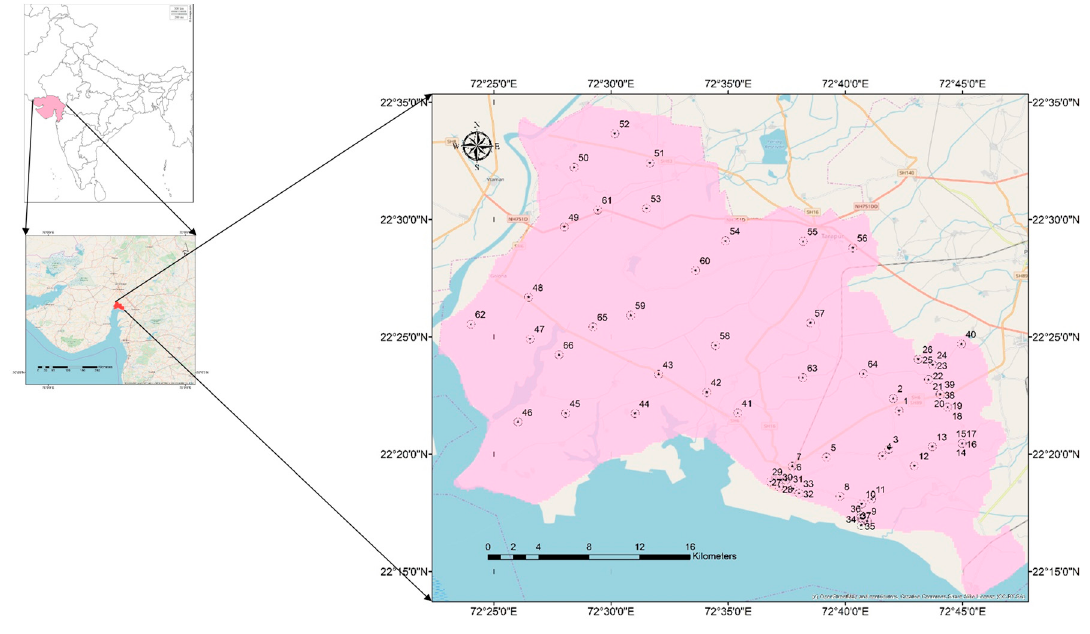
Figure 1. Study area map with sampling locations.